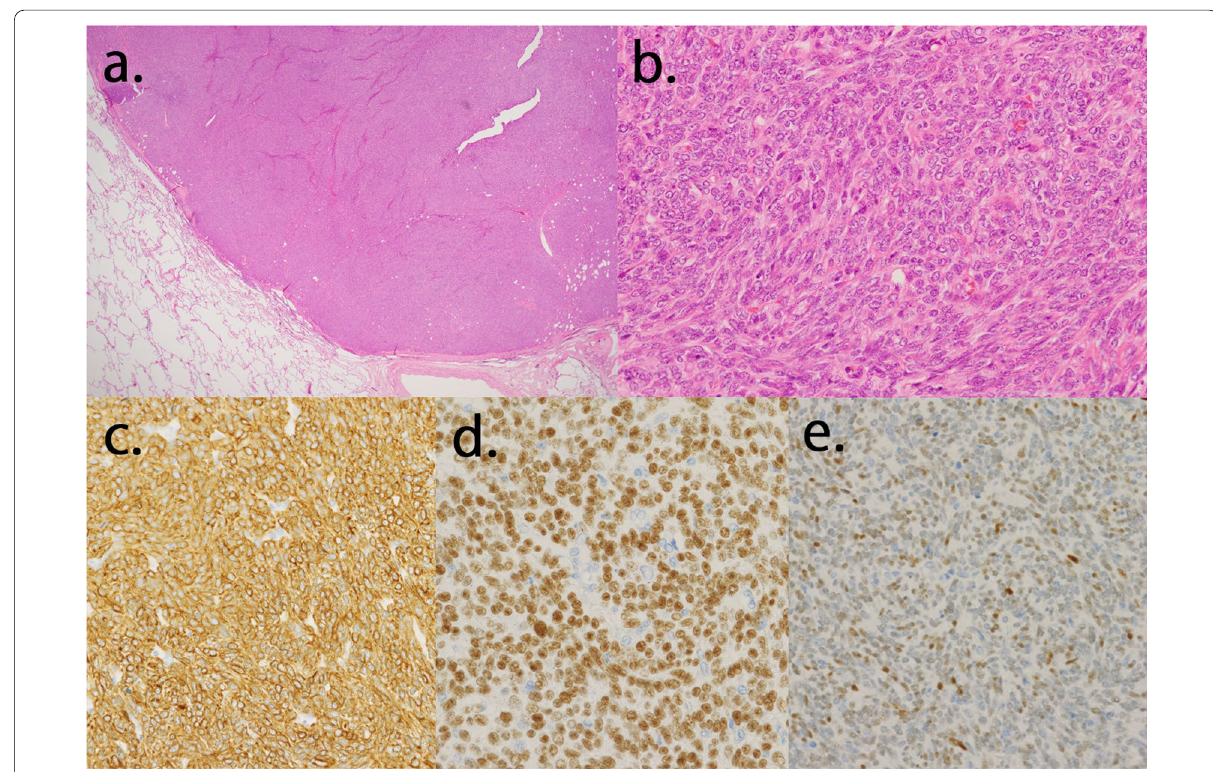
Fig. 4 a , b Hematoxylin and eosin staining of the pulmonary nodule. Pathological images are similar to those of an anterior mediastinal tumor. c – e An immunohistochemical analysis of the pulmonary disease. The tumor is noted to be positive for the anti-pan cytokeratin antibody ( c ), p40 ( d ), and paired box protein 8 ( e